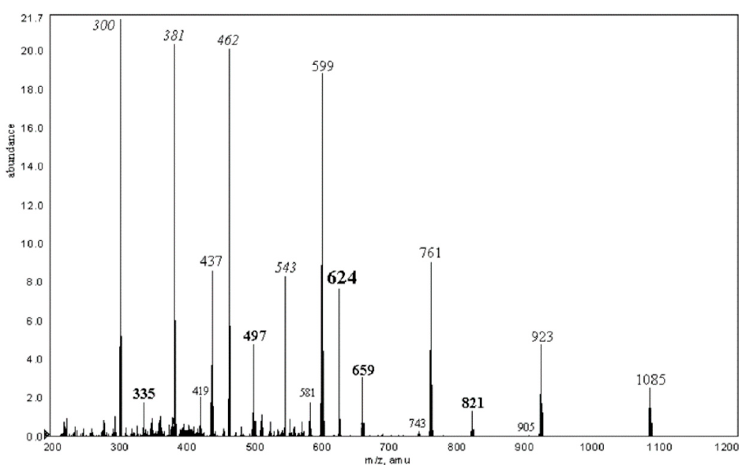
Figure 6. CID MS 2 of [ β -CD + Cd] 2+ ion at m / z 624 (reproduced from [33] with permission of Elsevier).